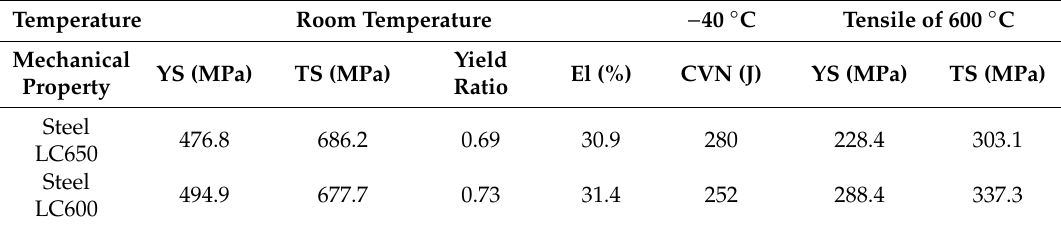
Figure 3. Vickers hardness and ferrite volume fraction in experimental steels. Table 2. Mechanical properties of the experimental steels.